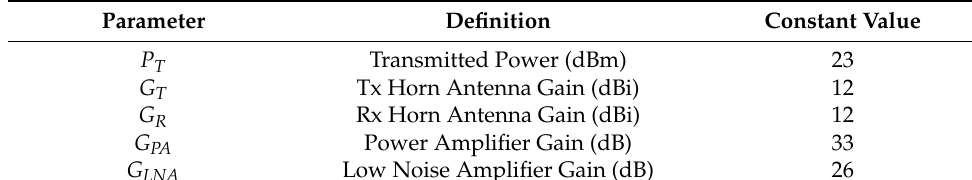
Table 1. Constant parameter values for measurement campaign.